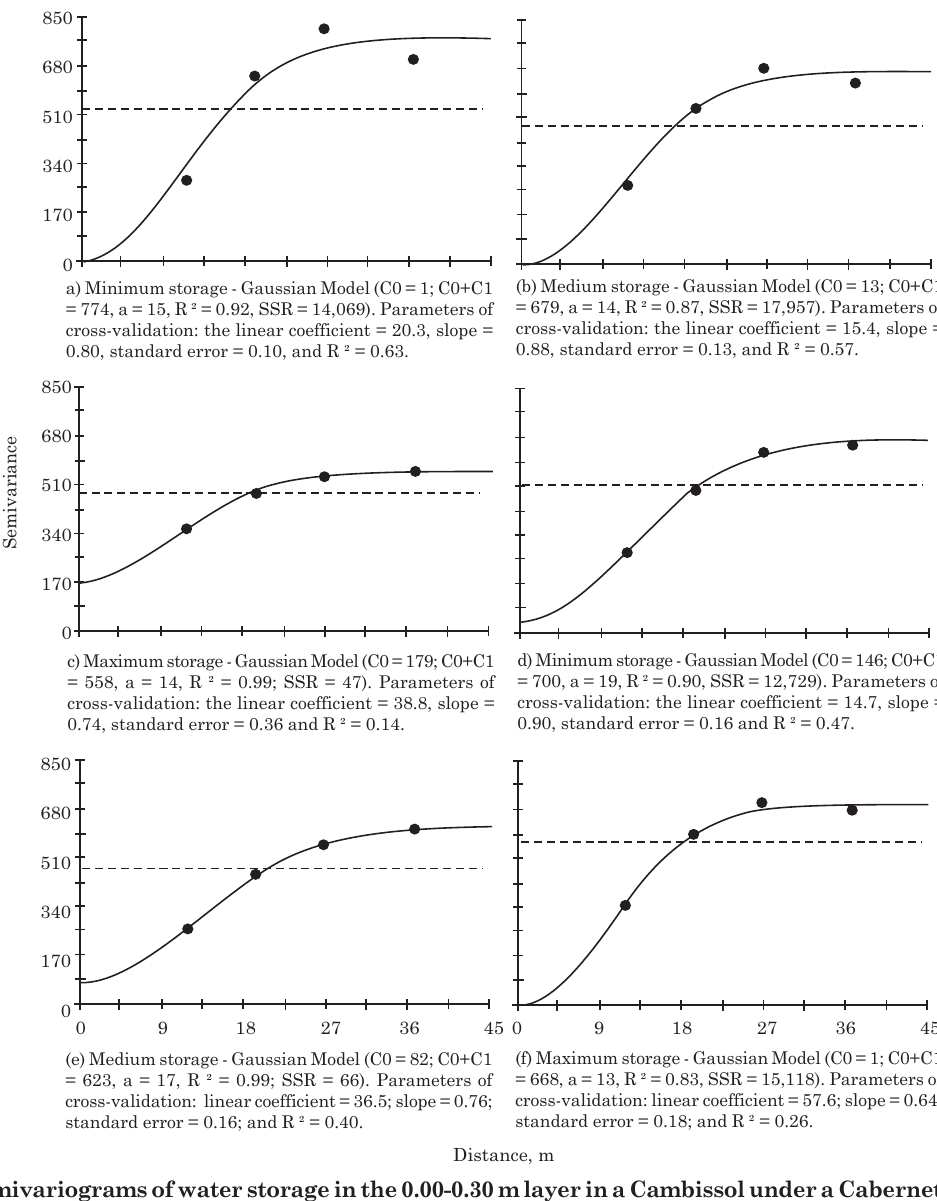
Figure 3. Semivariograms of water storage in the 0.00-0.30 m layer in a Cambissol under a Cabernet Sauvignon vineyard in the growing seasons 2008/2009 (a, b, c) and 2009/2010 (d, e, f). C0: nugget effect, C0+C1: lsill range a meters, R ²: coefficient of determination, and SSR: sum of squared